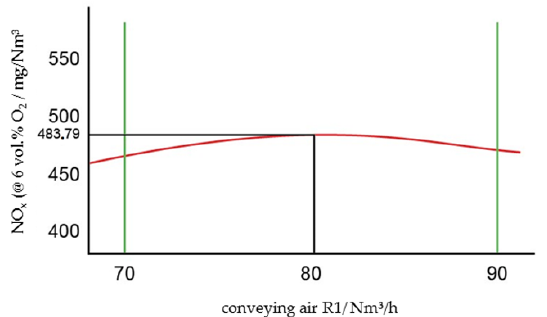
Figure 11. Sensitivity in the case of additional conveying air via annular gap 1 with respect to NO x .